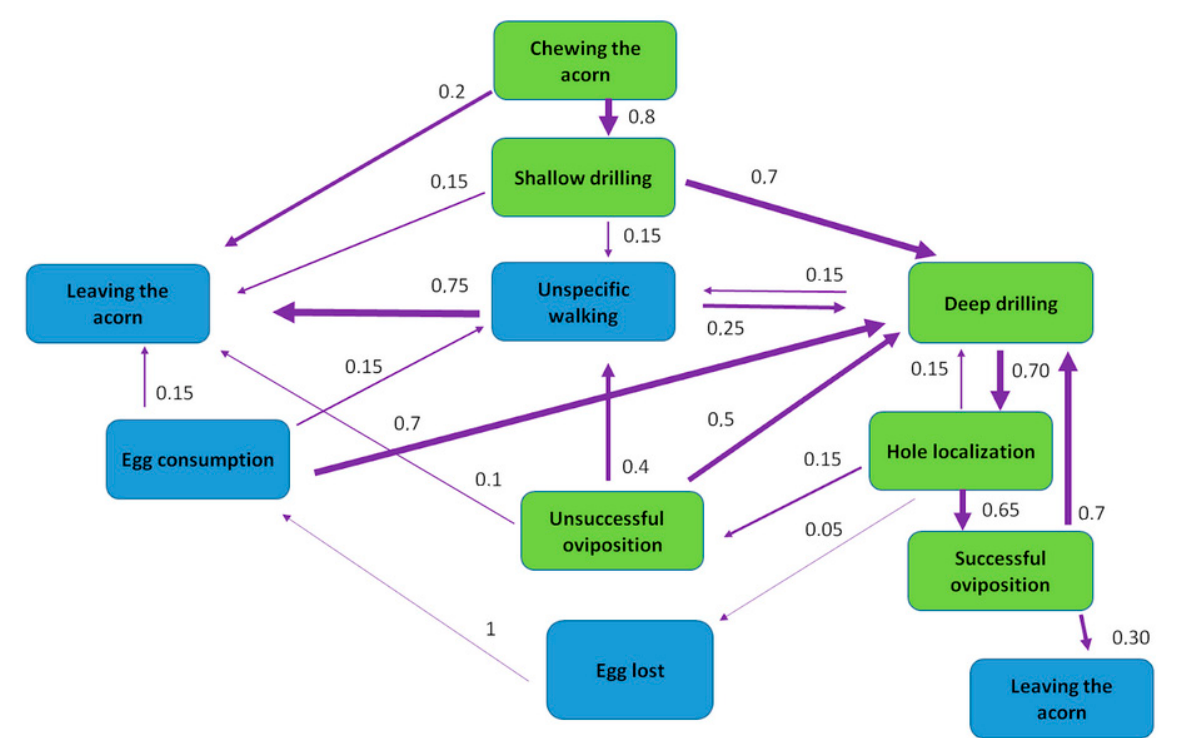
Figure 4. Flow chart scheme representing the sequence of a typical female behavior during oviposition (n = 27): green color—ovipositional activities, blue—non-related behavior; arrow thickness indicates frequency of behavior; numbers stand for the probability of turning one behavior into another.